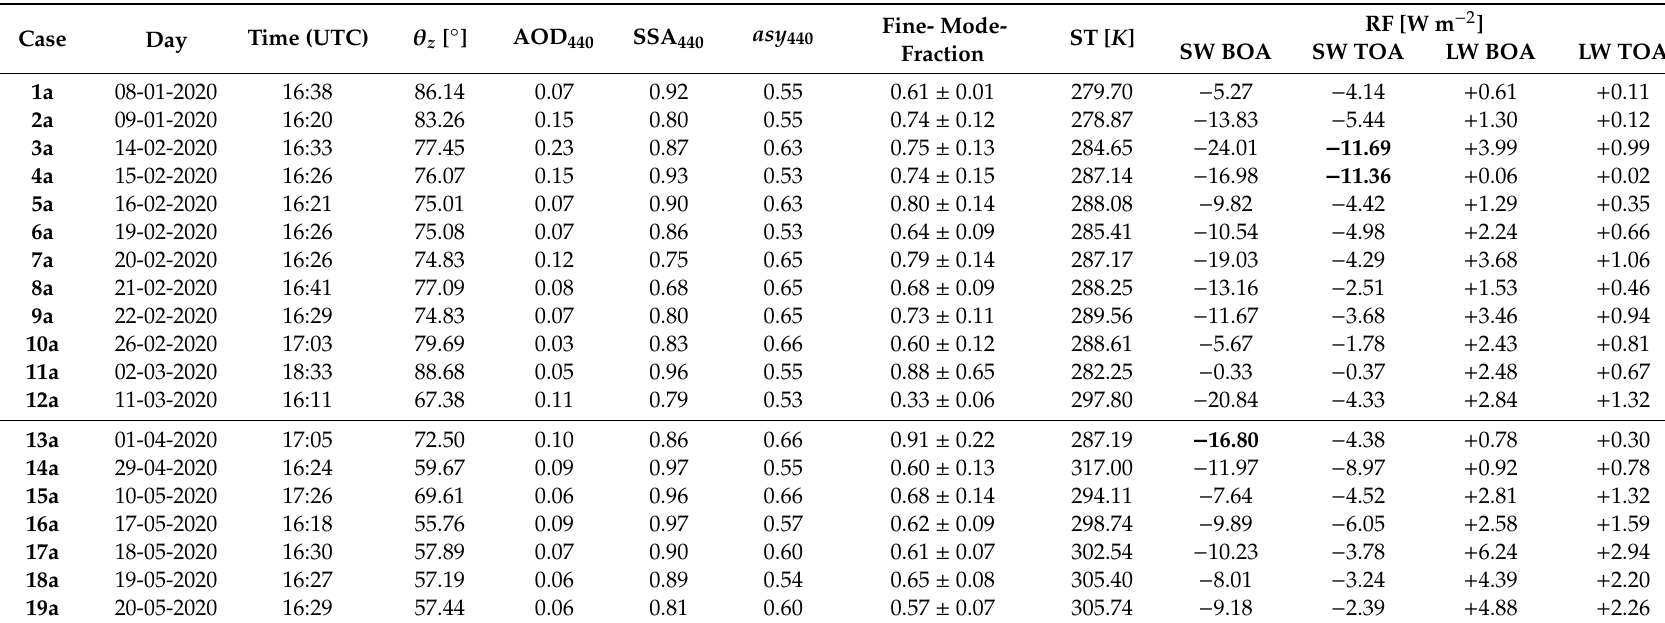
Table 5. Aerosol radiative forcing (last four columns), estimated for 30 di ff erent afternoons without presence of mineral dust in the atmosphere, at the BOA and the TOA for the LW and SW. Time refers to the ceilometer start time (all ceilometer measurements are of a duration of 2 h). Fine-mode-fraction is shown together with its standard deviation, provided by AERONET. The letter “a” in the case number denotes that these are afternoon cases. Radiative forcing estimates considered as outliers by the boxplots (see Figures 5 and 6) are marked in